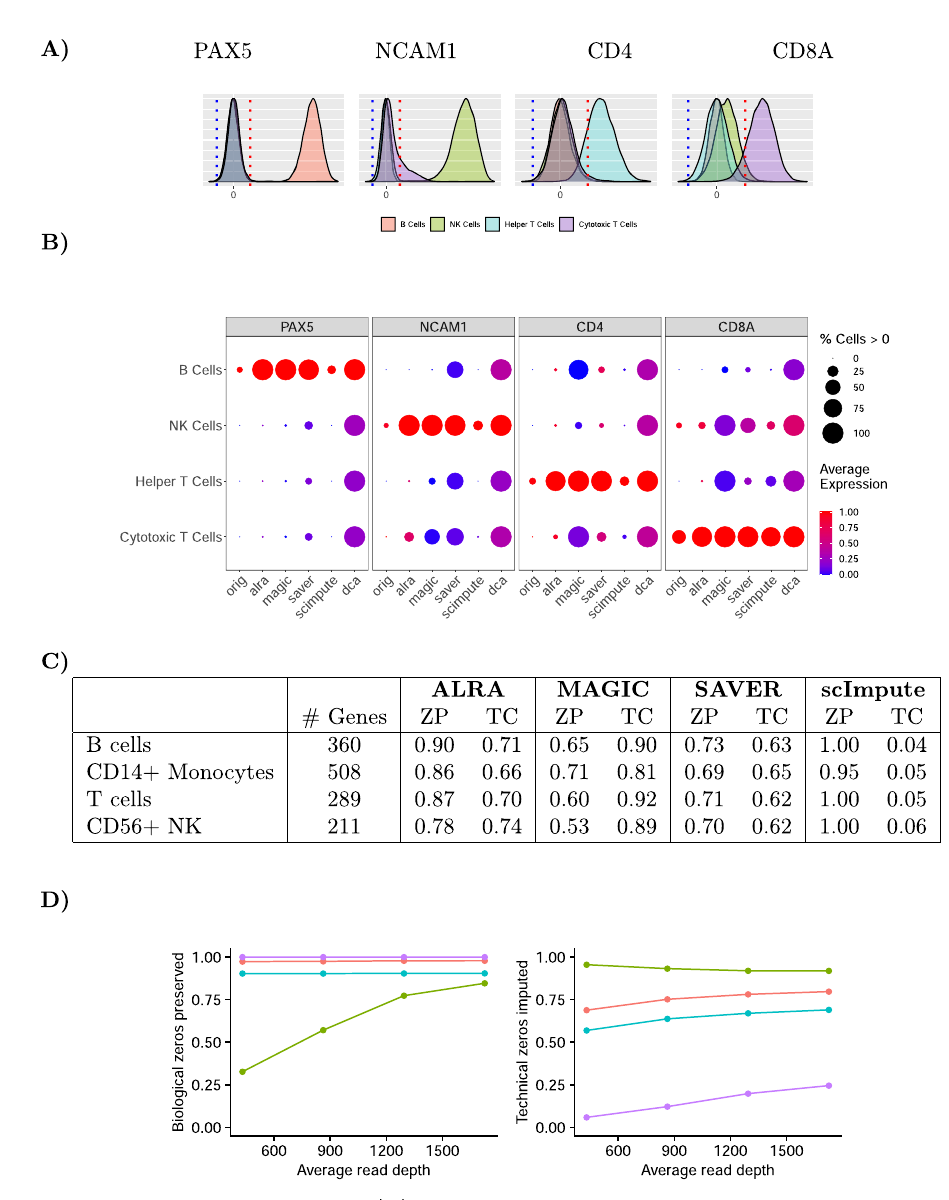
Fig. 2 Preserving biological zeros in puri fi ed PBMC populations. A After low-rank approximation, ALRA recovers biological zeros of each gene by thresholding (red line) the expression values of that gene in all cells at the magnitude of the p = 0.001 quantile of that gene (blue line). B Preserving biological zeros in genes known to be speci fi c to each cell population. C Biological zeros were de fi ned as genes which should not be expressed in a cell type (based on bulk RNA-seq). The ratio of these biological zeros preserved (ZP) is shown alongside the ratio of total zeros completed (TC). D Percentage of biological zeros preserved (left) and technical zeros completed (right) in a simulated scRNA-seq dataset as sequencing depth increases. DCA not shown for ( C ) and ( D ), as it imputes every zero to a positive